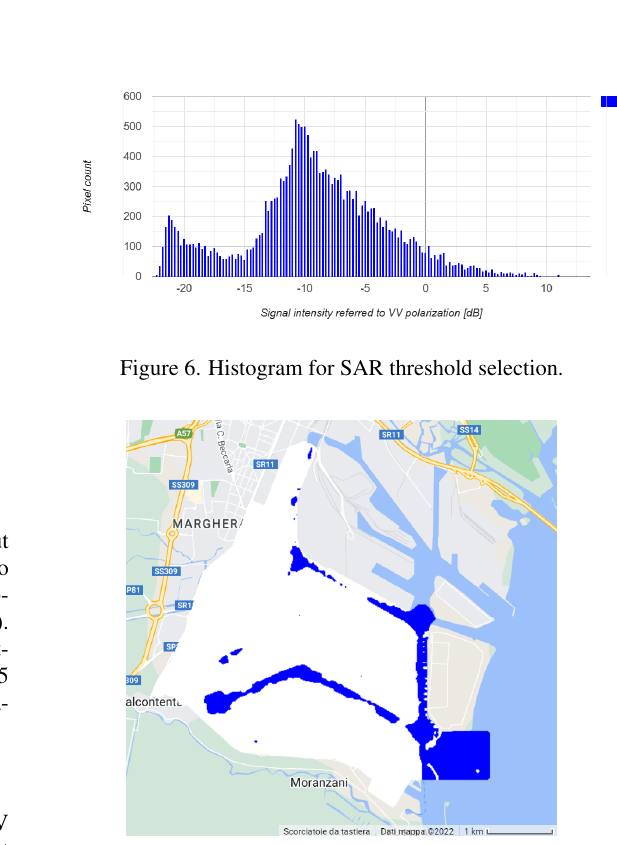
Figure 5. Water segmentation image obtained with the HSV approach using Sentinel imagery.